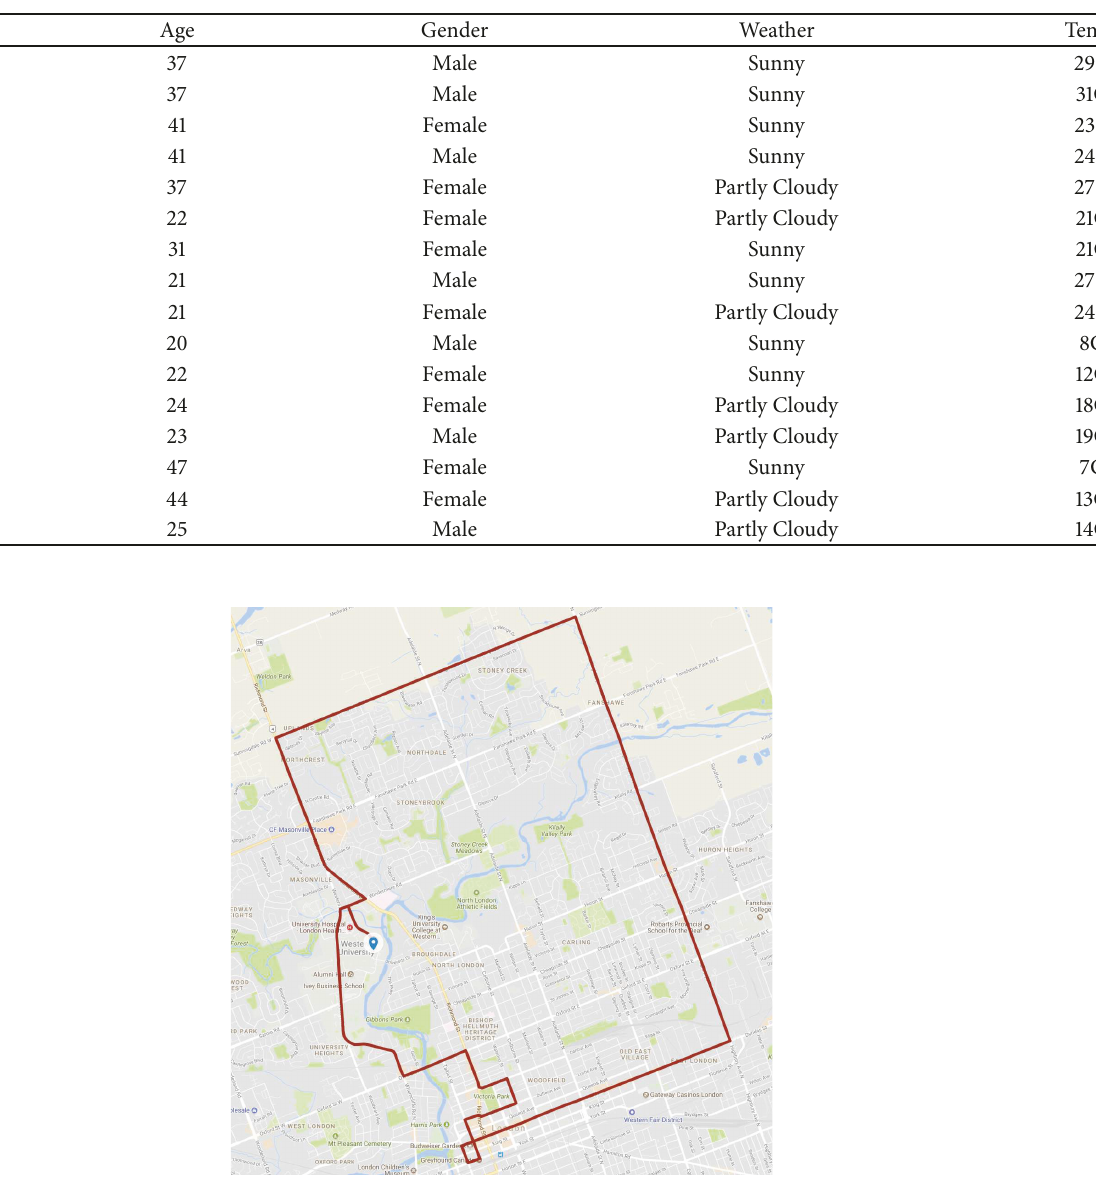
Table 1: Characteristics of drivers and environment.